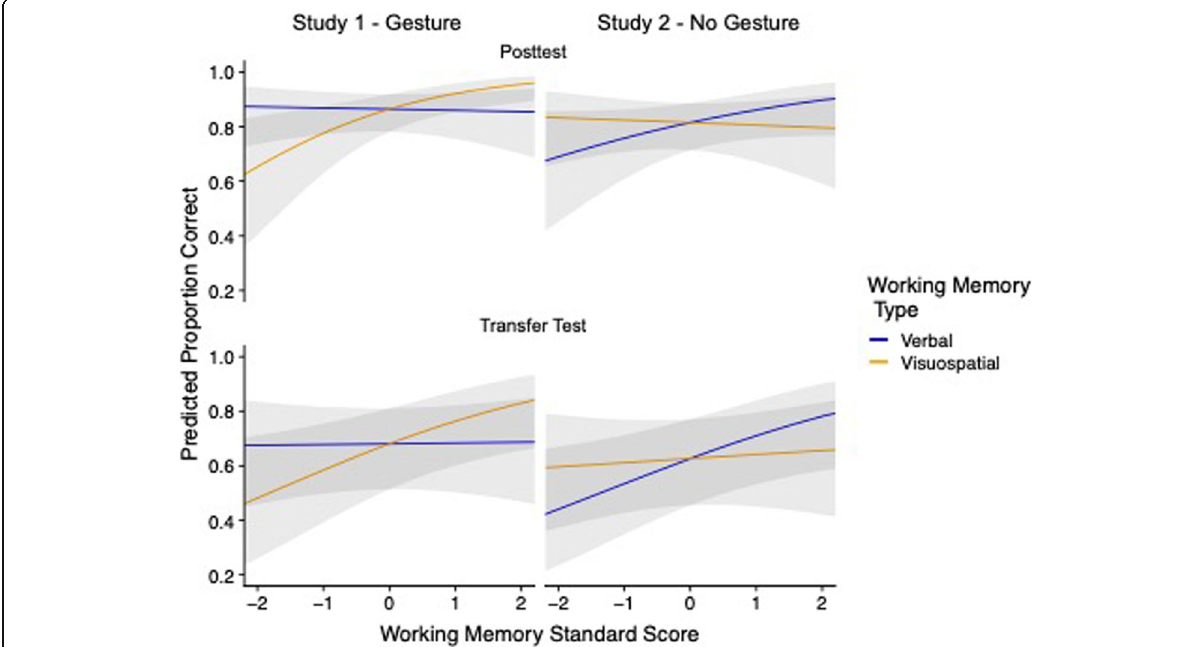
Fig. 2 Model predictions from the combined analysis of Study 1 ( left column ) and Study 2 ( right column ) for the posttest ( top row ) and the transfer test ( bottom row ). The multilevel logistic models predicted posttest or transfer test performance from two-way interactions between gesture group and verbal working memory span, and gesture group and visuospatial working memory span, with composite ACT score as a covariate, and random intercepts for participant and problem. For graphical purposes, performance was separately predicted from verbal and from visuospatial working memory capacities while holding all other variables in the model constant. Error bars represent the 95% confidence interval of the